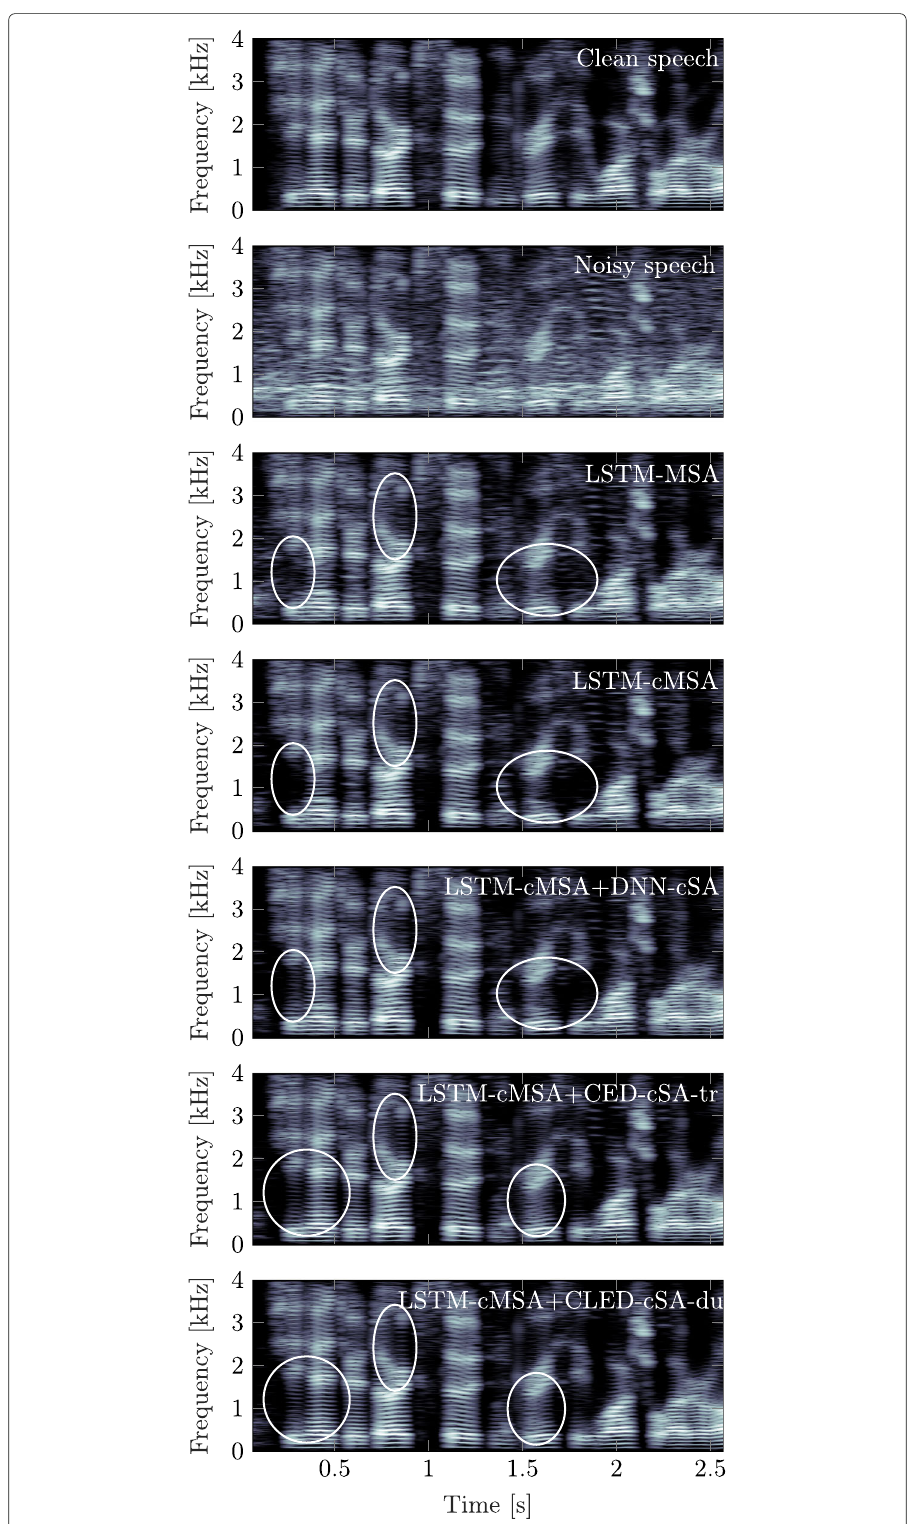
Fig. 6 Spectrograms of reference and enhanced speech for a male speaker in unseenpubnoise at 5 dB SNR. From top to bottom: clean speech, noisy speech, LSTM-MSA, LSTM-cMSA, new LSTM-cMSA+DNN-cSA, proposed LSTM-cMSA+CED-cSA-tr, and high-complexity reference